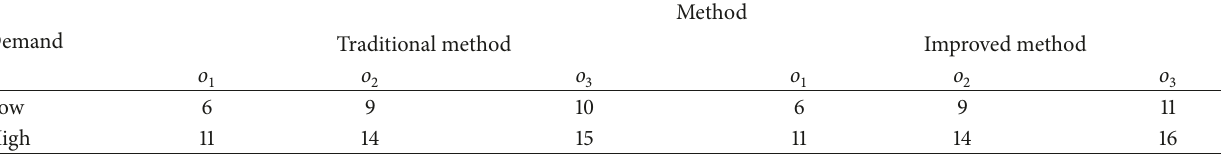
Table 10: Clearance time of residential communities.